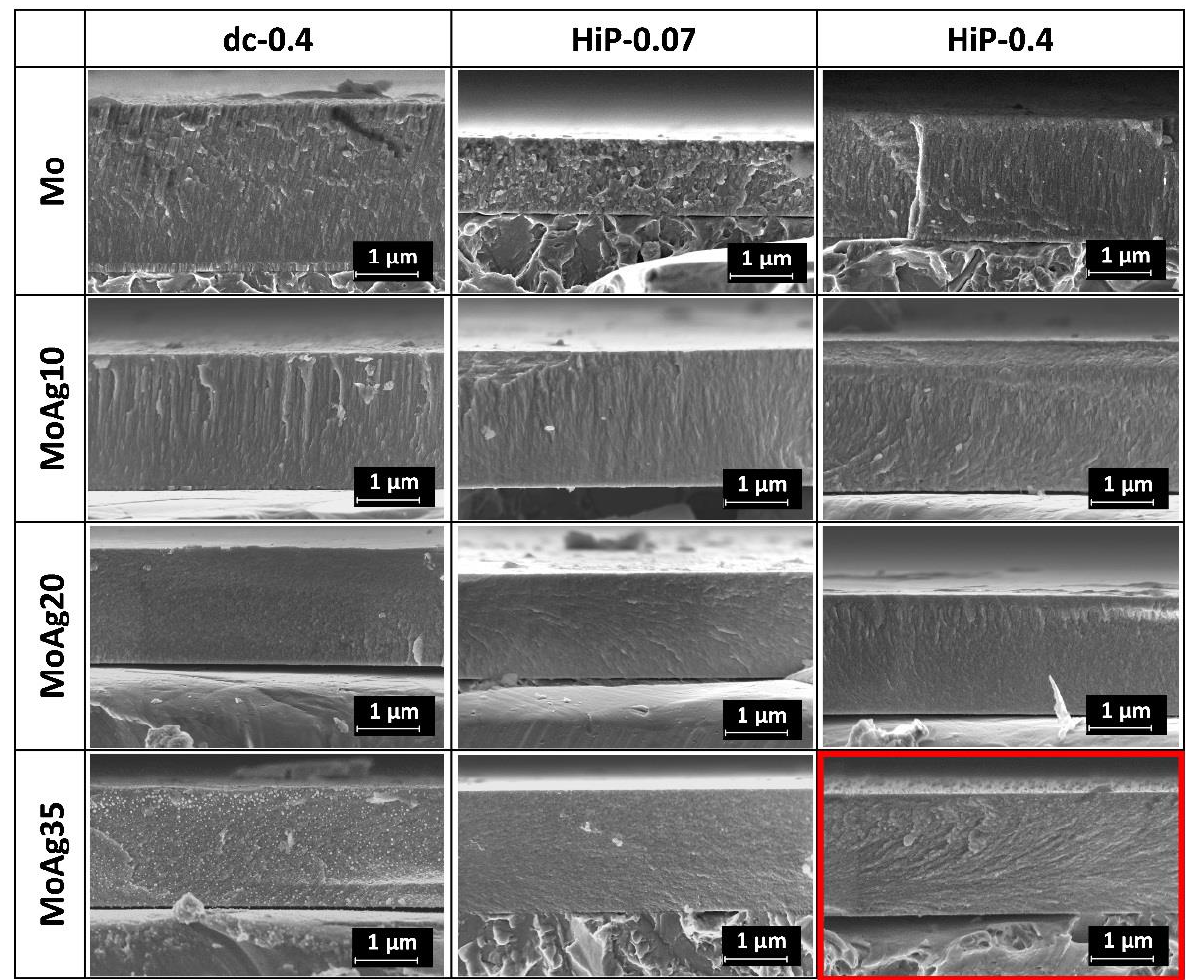
Figure 7. SEM micrographs of fracture cross sections of the samples from the 3 series with floating substrate bias voltage.